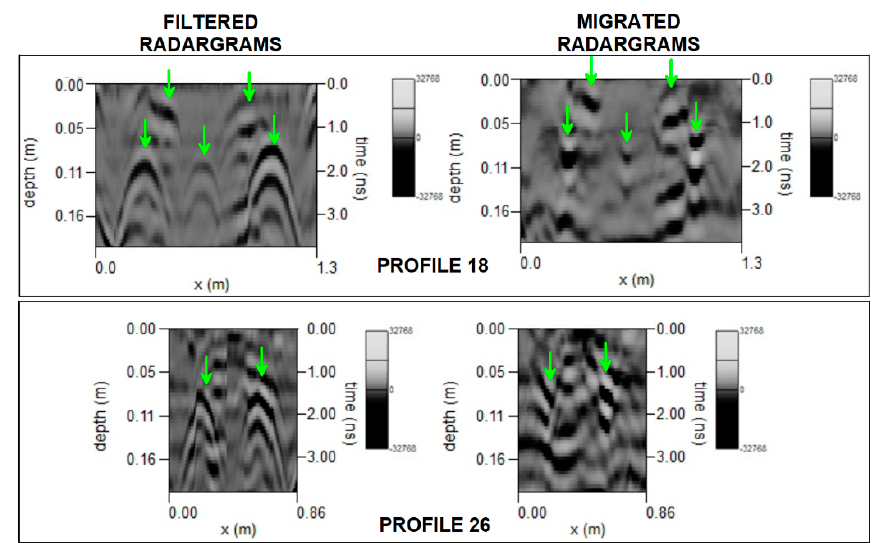
Figure 11. Filtered and migrated radargrams of profiles 18 and 26.